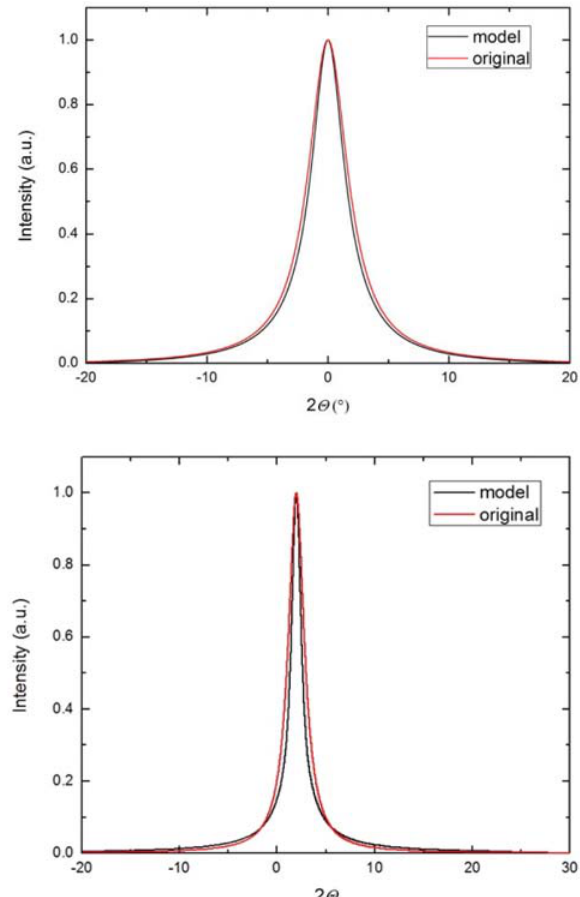
Figure 7. Comparison of the separated profiles with the original